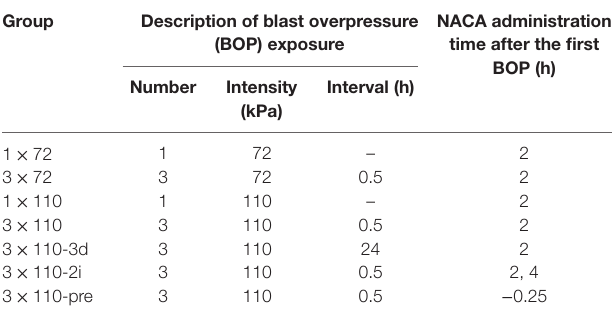
TaBle 1 | grouping of animals based on number and intensity of blasts, interval between blasts, and administration of N -acetylcysteine amide (naca). group Description of blast overpressure (BOP)